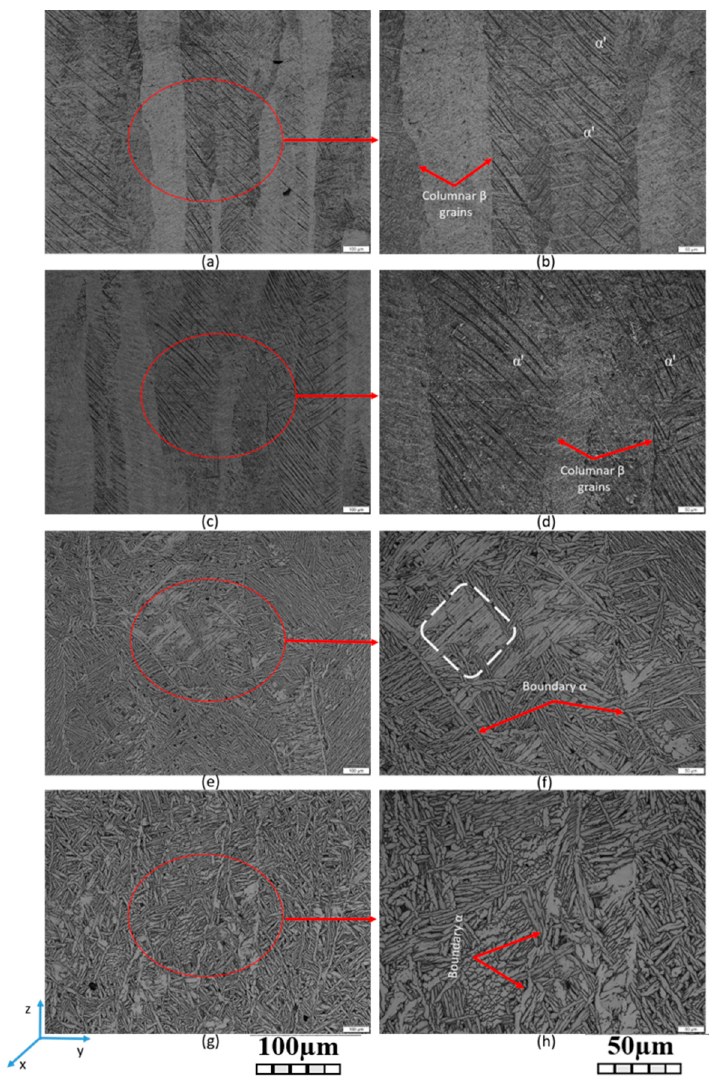
Figure 3. Optical microstructures of the samples: ( a ) As ‐ built; ( b ) as ‐ built zoom in; ( c ) 700 °C; ( d ) 700 °C zoom in; ( e ) 950 °C; ( f ) 950 °C zoom in; ( g ) 1000 °C; ( h ) 1000 °C zoom in.